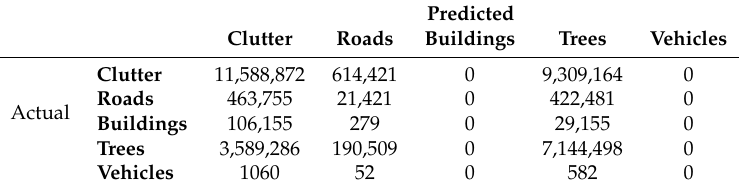
Table A2. Confusion matrix for the GSCNN model that is trained on coordinates, after 50 epochs.